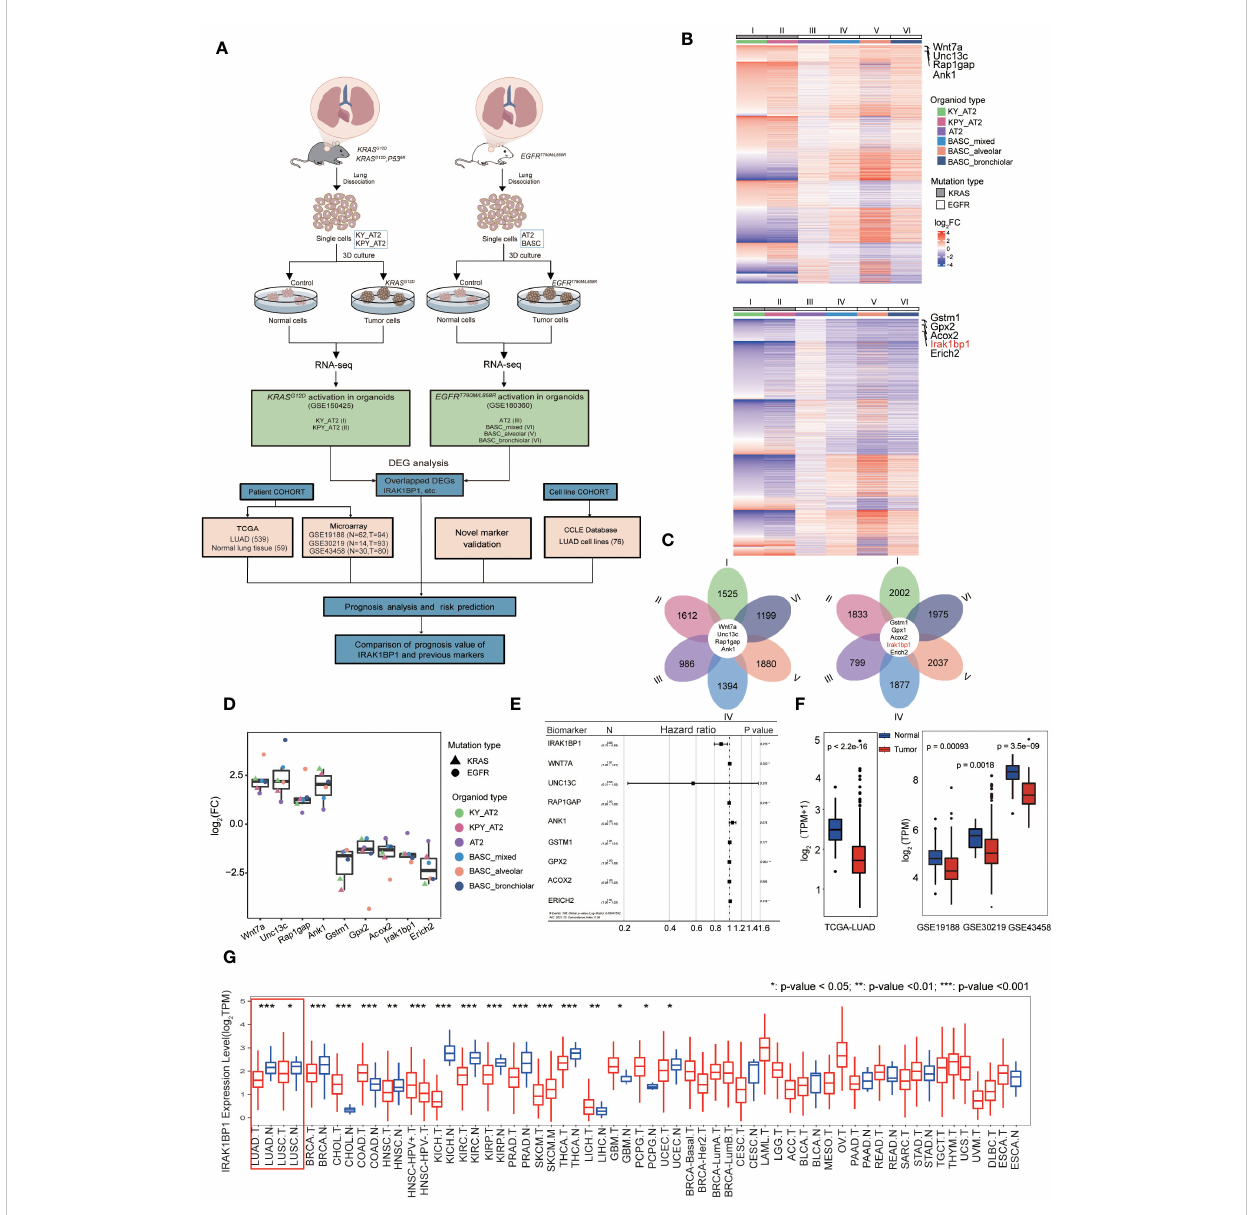
FIGURE 1 IRAK1BP1 is downregulated in six different organoid types. (A) Schematic describing the work fl ow for identifying NSCLC-speci fi c DEGs from publicly available RNA-sequencing data from organoids with the indicated oncogenic mutations and cell of origin. FACS sorting, in vitro propagation, activation of KRAS or EGFR were performed for lung cells harvested from mice with the indicated genotype. In the KRAS-driven lung cancer, organoids were developed from dissected lungs of adult KRAS LSL-G12D ; ROSA26 LSL-YFP (KY), KRAS LSL-G12D ; P53 fl / fl ; ROSA26 LSL-YFP (KPY) mice and used FACS to isolate alveolar type 2 (AT2) cells. In the EGFR-driven lung cancer, organoids were developed from the dissecting lungs and tracheas of EGFR T790M/L858R mice and used FACS to isolate AT2 cells and bronchioalveolar stem cells (BASCs). Organoids derived from BASCs were manually subcloned into alveolar, bronchiolar, and mixed cultures by their microscopic morphologies. Both of alveolar and bronchiolar organoids are contained in mixed BASCs. (B) Heatmap of DEGs that were expressed in six models. Top: the total upregulated genes; bottom: the total downregulated genes. (C) Petal diagrams showing the numbers of differentially expressed genes in each dataset and their overlap. Left: the numbers of up-regulated genes in the six models; right: the numbers of down-regulated genes in the six models. (D) Symbols showing the fold-change in log2FC of common DEGs in all 6 datasets and means ± SD are indicated. (E) Multivariable Cox regression of candidate LUAD biomarker genes in the TCGA LUAD cohort (n = 539). (F) The expression of IRAK1BP1 in LUAD and corresponding normal lung tissues. (G) The differential expression of IRAK1BP1 between normal tissues and tumor tissues in various cancers. *P < 0.05, **P < 0.01, and ***P <